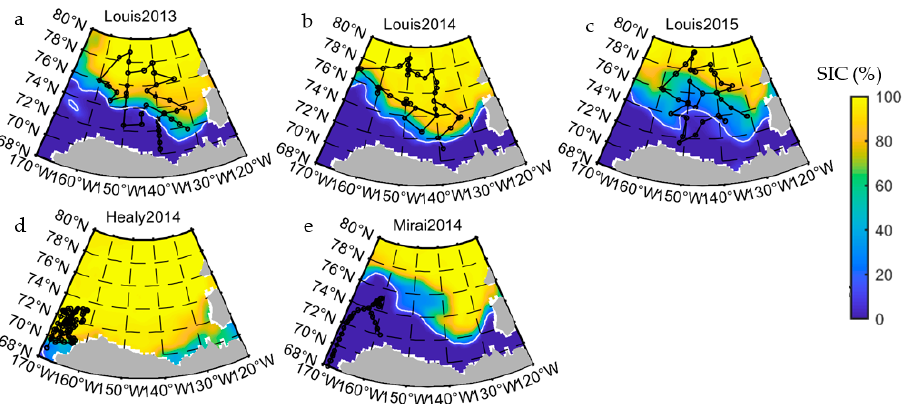
Figure 1. Cruise routes and mean sea ice concentration (SIC, %) during Louis 2013 (( a ), from 6 August to 31 August), Louis 2014 (( b ), from 26 September to 15 October), Louis 2015 (( c ), from 24 September to 12 October), Healy 2014 (( d ), from 17 May to 20 June) and Mirai 2014 (( e ), from 5 September to 28 September). Each circle with line linking shows the location of each observation along the cruise. The base colors in shading show the mean ERA5 sea ice concentration during each cruise, while the white solid line represents the 15% sea ice concentration